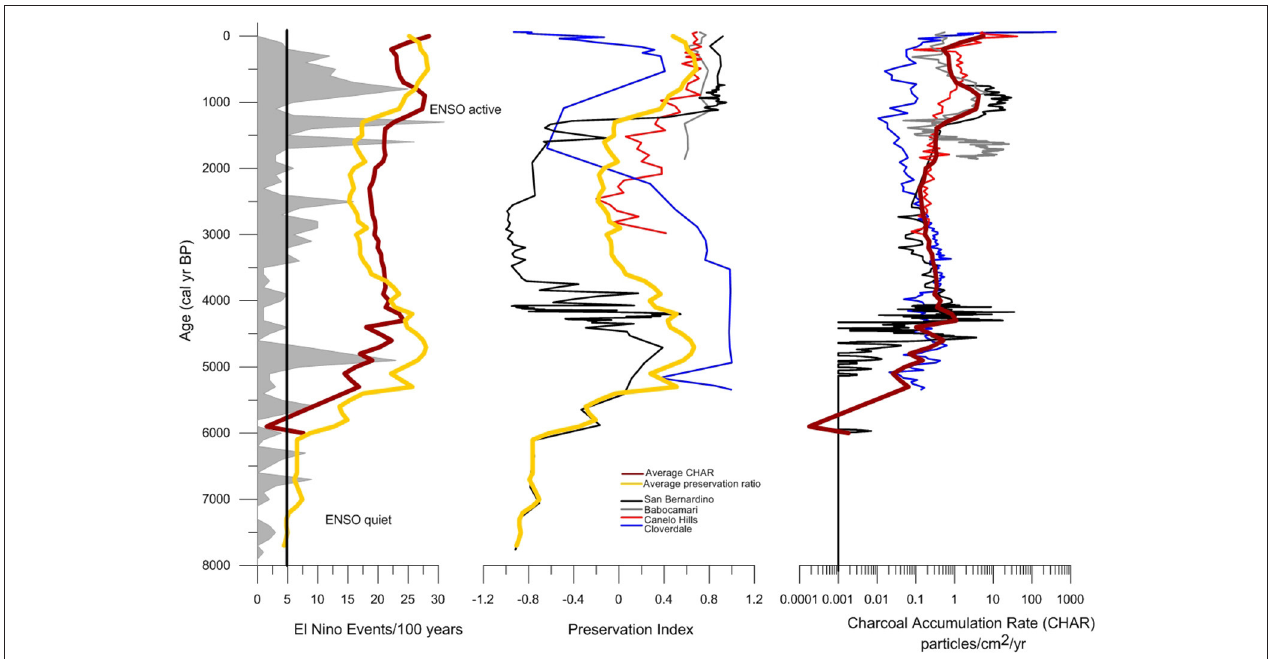
FIGURE 7 | Synthesis figure which includes Moy et al. (2002) El Niño frequency curve, the pollen preservation index and charcoal influx for all four sites. An average of all the sites CHAR and pollen preservation indices are included to show broad